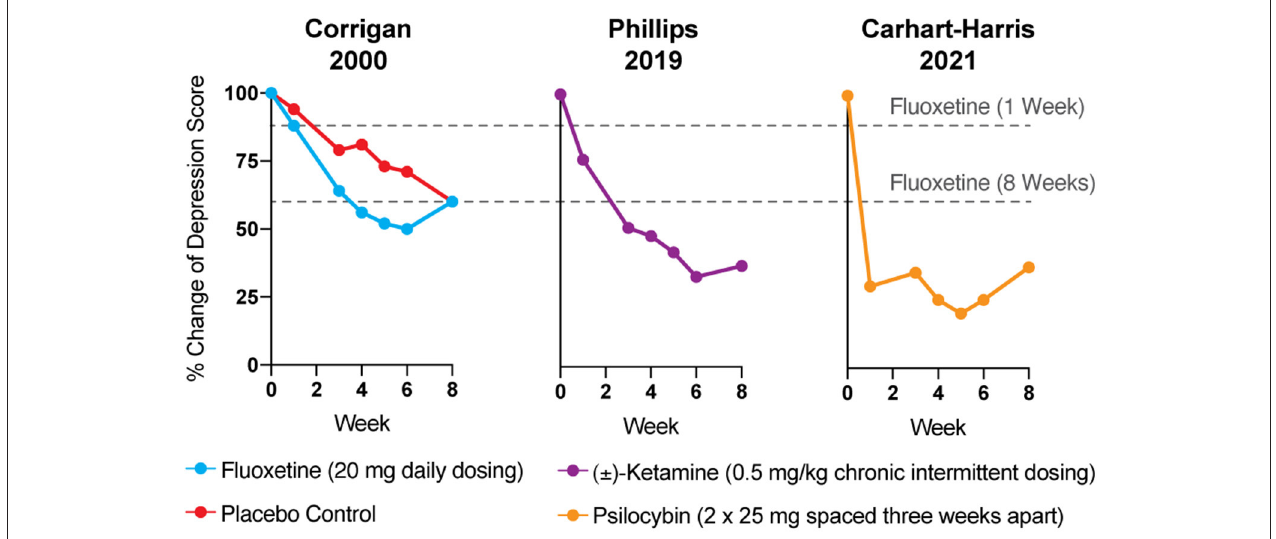
FIGURE 1 | The antidepressant effects of psychoplastogens (e.g., ketamine and psilocybin) are more rapid and sustained than those of traditional antidepressants (e.g., fluoxetine). Data adapted from three clinical trials evaluating the effects of fluoxetine (6), ketamine (7), and psilocybin (8) for treating depression. Dashed lines represent the efficacy of either 1 or 8 weeks of fluoxetine treatment.